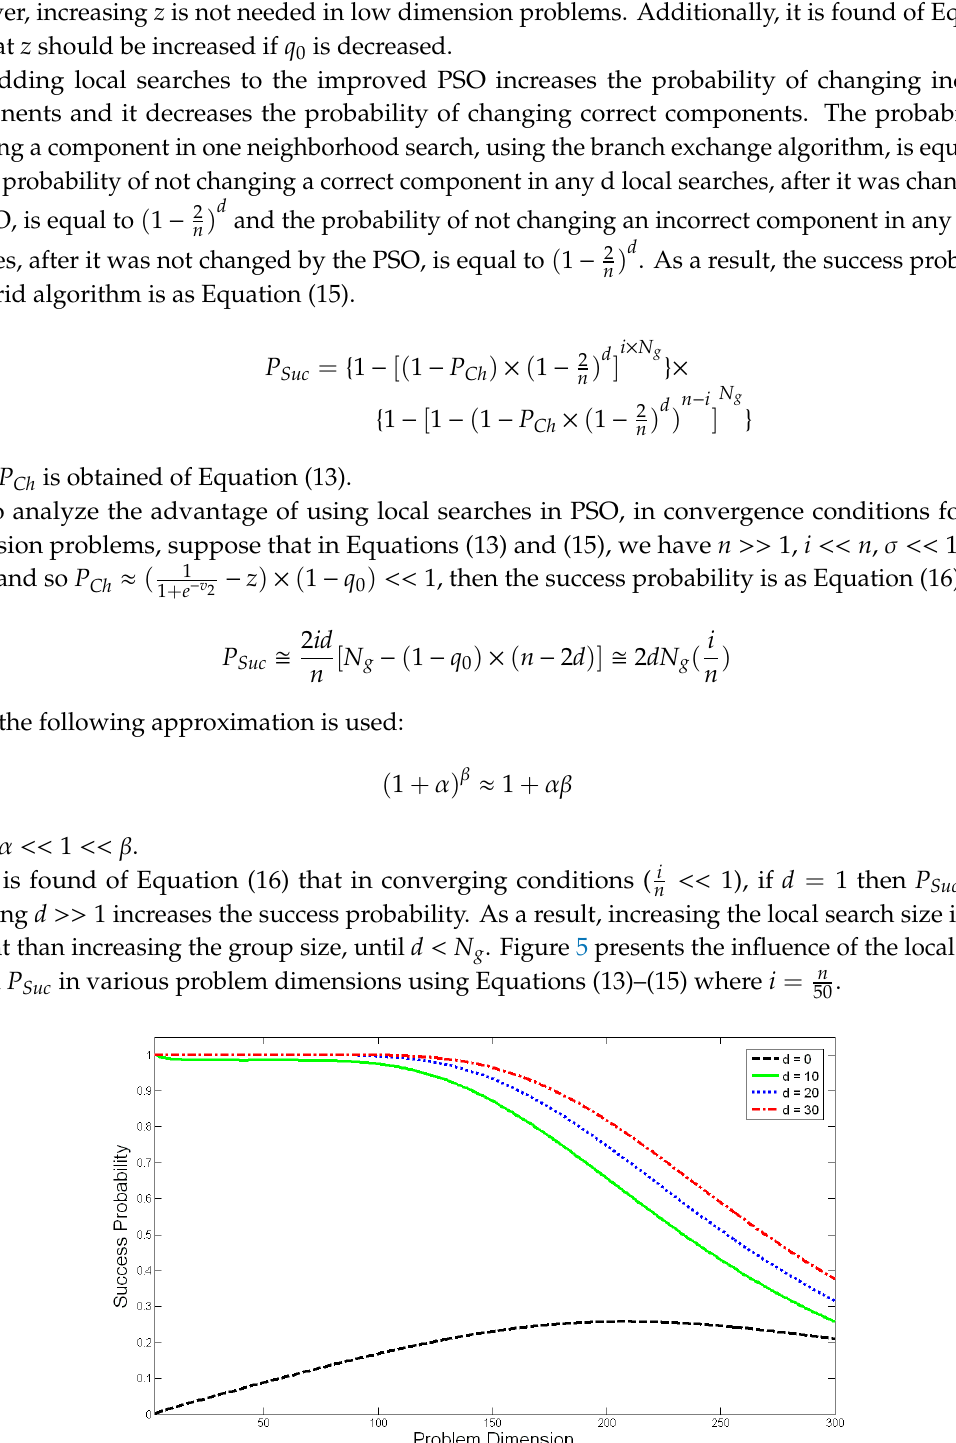
Table 1. Economic data for numerical studies. Economic Parameters